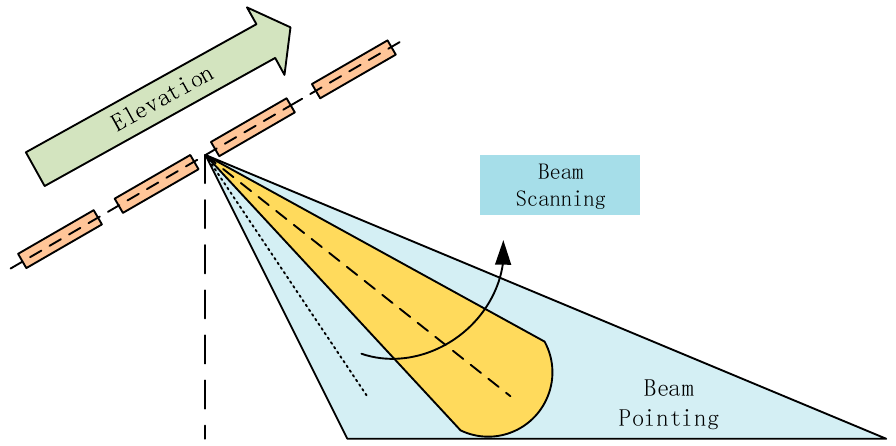
Figure 1. DBF geometric schematic diagram.